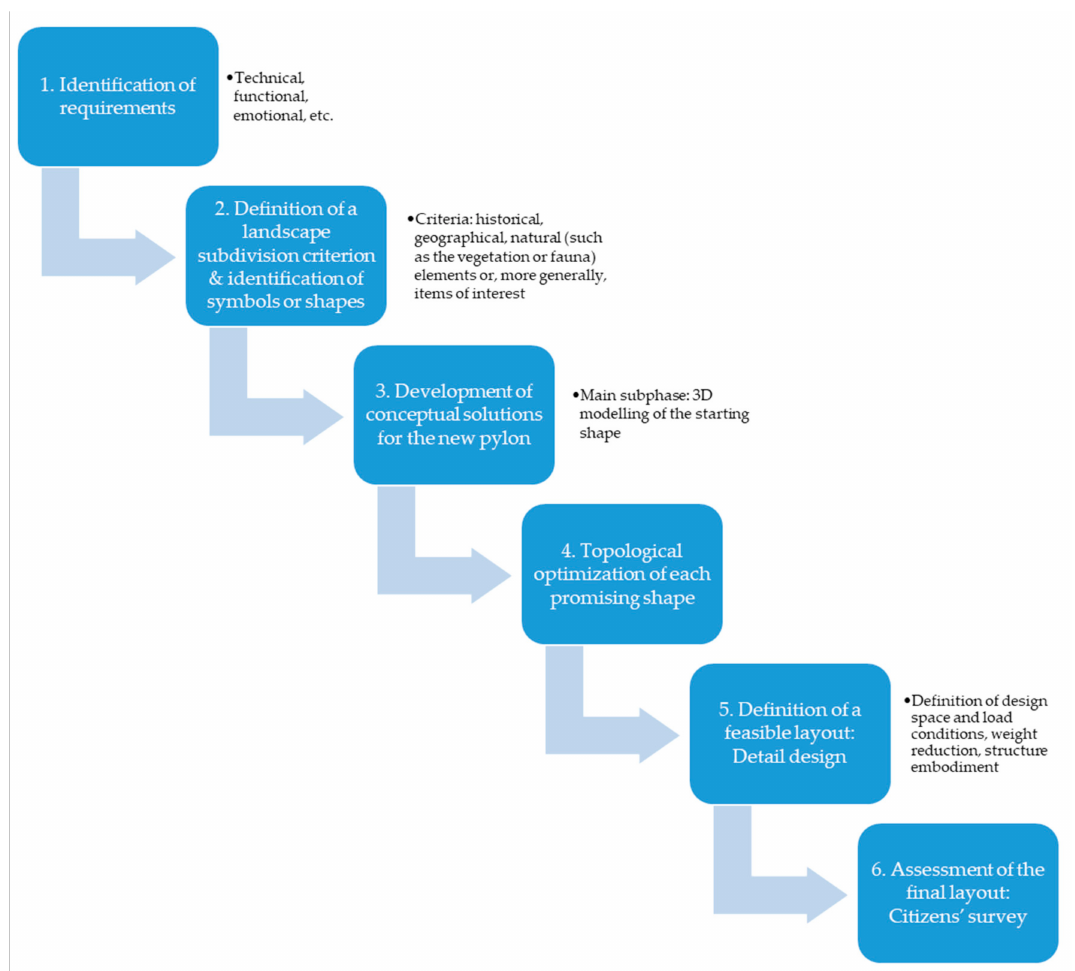
Figure 2. Flow-chart of the proposed